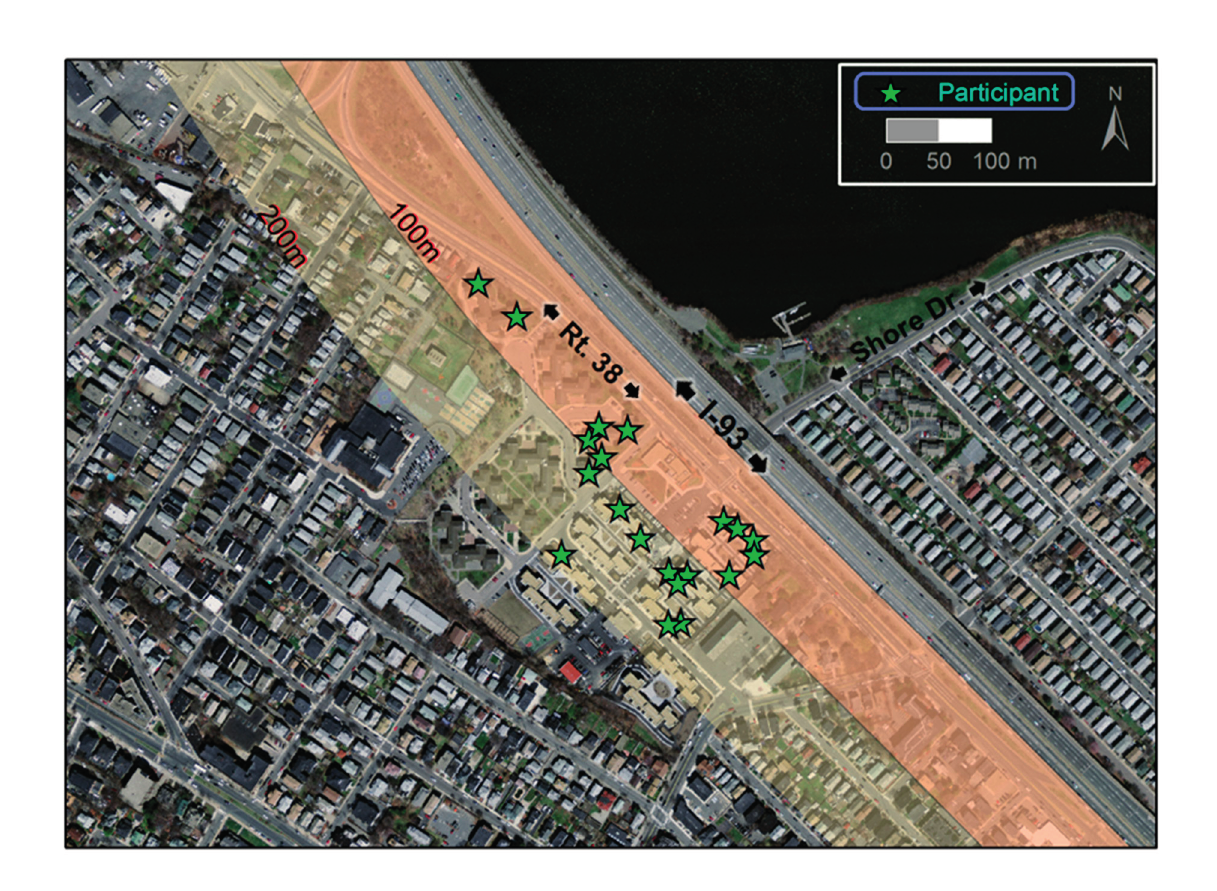
Figure 1. Map of study area and locations of participant apartments. Orthophoto was downloaded from MassGIS